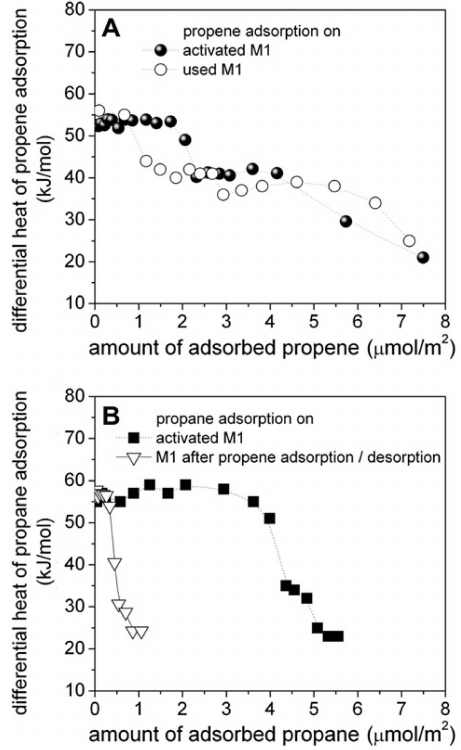
Figure 14. ( A ) Heat of propene adsorption on M1 MoVTeNb oxide before (filled circles) and after propane oxidation (open circles; reaction conditions of propane oxidation: 400 ˝ C, C 3 /O 2 /H 2 O/ N 2 = 3/6/40/51). ( B ) Heat of propane adsorption on activated (fresh) M1 MoVTeNb oxide, (filled squares) and after adsorption and subsequent desorption of propene at 40 ˝ C (open triangles). The differential heat of adsorption is plotted as a function of coverage normalized to the specific surface area (from [88] copyright 2015, Elsevier